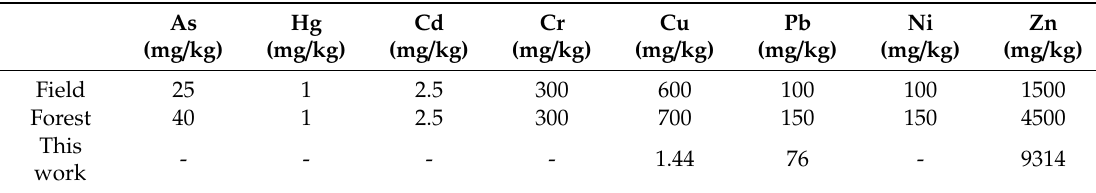
Table 4. Limit values for heavy metals according to the Fertilizer Product Decree 24 / 2011 (Finnish Ministry of Agriculture and Forestry). Limit for copper and zinc can be exceeded if soil analysis indicates